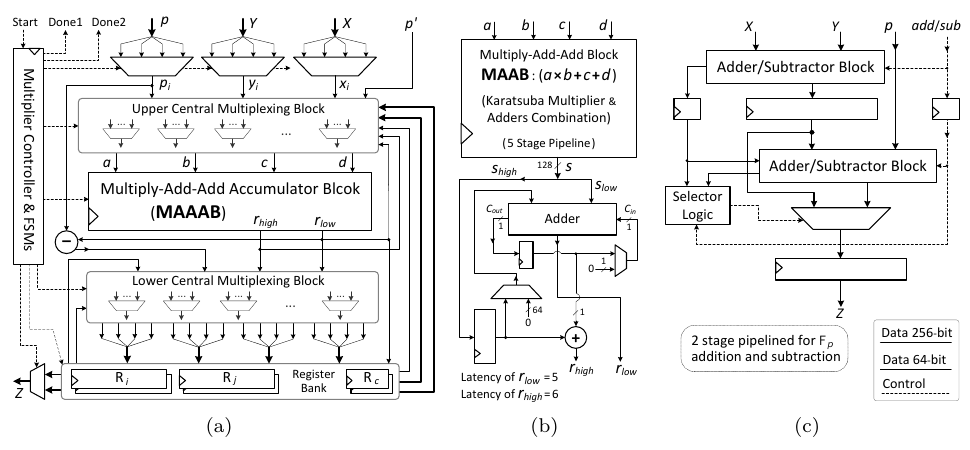
Figure 8: Structures of (a) MMMB, (b) MAAAB, and (c) MASB blocks [BJ20a].